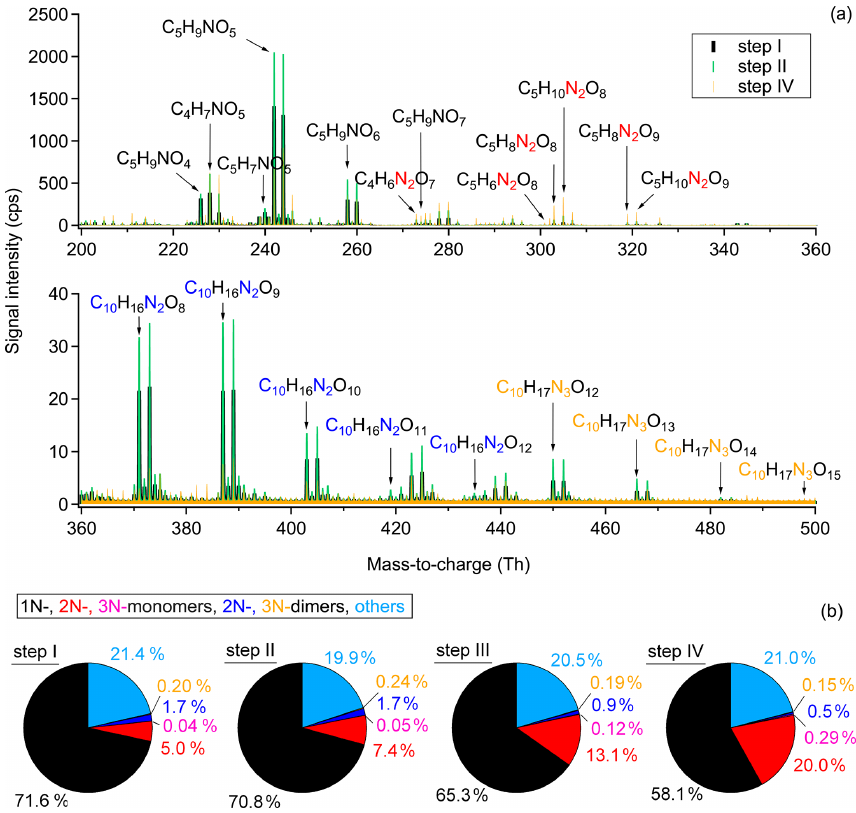
Figure 3. Comparison of the chemical composition of each oxidation step. (a) Averaged mass spectra for step I, II, and IV, with the omitted spectrum of step III being very similar to that of step II. (b) Relative contribution of different chemical groups for each oxidation step. Only organic products were counted for analysis. “Others” refers to CHO compounds that do not contain nitrogen atoms (e.g., C 5 H 8 O 2 and C 5 H 8 O 3